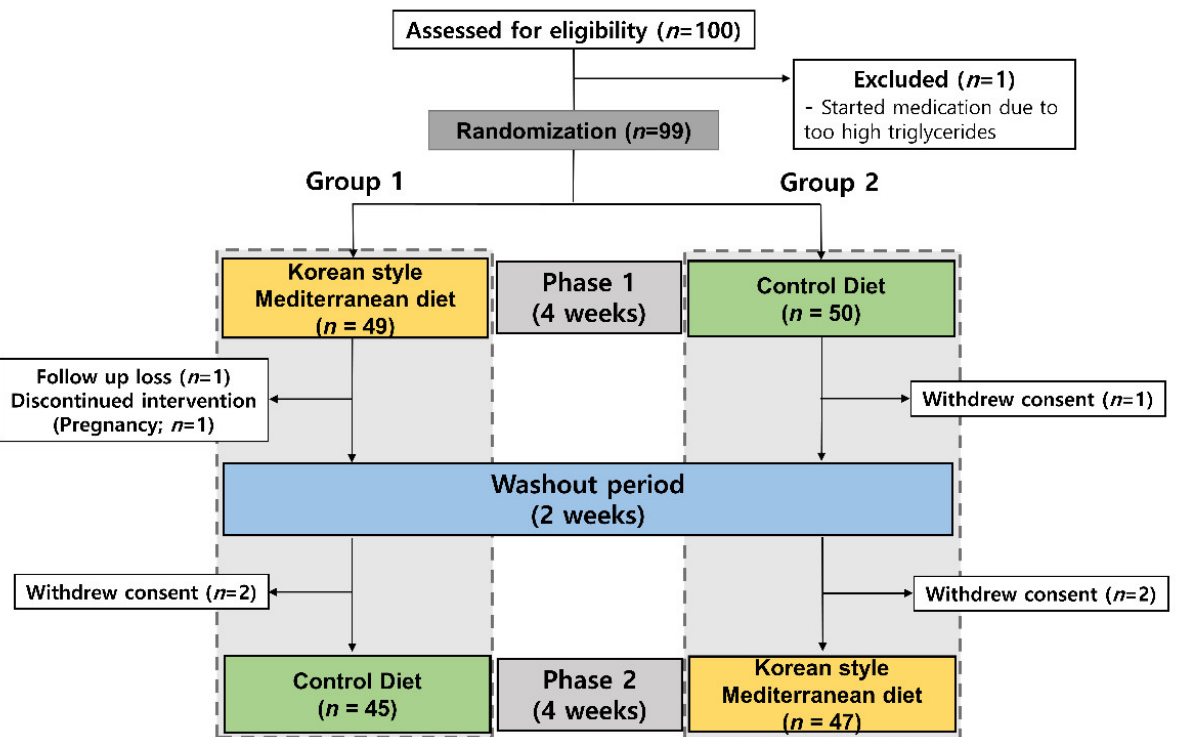
Figure 1. Flow chart of study cohort enrollment, allocation, and completion.